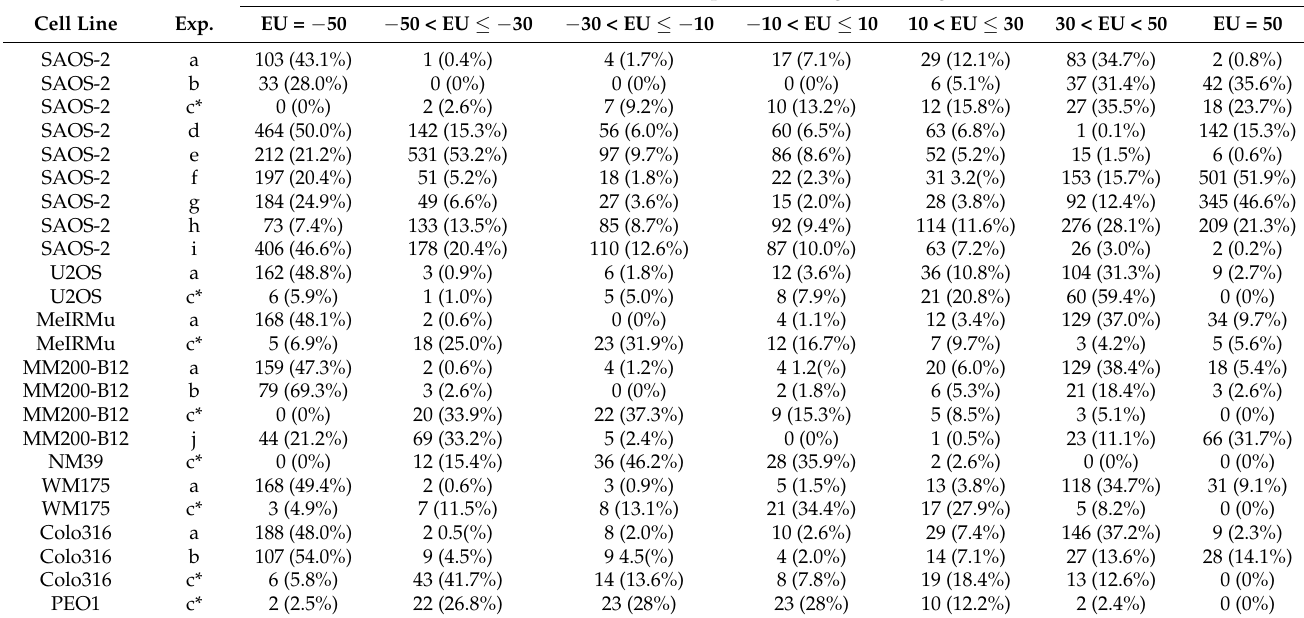
Table 2. The number of co-cultured cells according to Exchange Units (EU) in each experiment. The relative percentage of cells in each co-cultured group is indicated in brackets (%) to aid comparison. Ostesoarcoma (SAOS-2, U2OS), melanoma (MeIRMu, MM200-B12, NM39, WM175), colon carcinoma (Colo316) and ovarian carcinoma (PEO1) cells were studied. All experiments were with human dermal fibroblasts, labelling fibroblasts with DiD and cancer cell lines with DiO, except for experiment ‘i’ where SAOS-2 expressed GFP, and experiment ‘c’ (marked *), where human gingival fibroblasts were used and labelling had the opposite orientation, such that fibroblasts were pre-labelled with DiO and cancer cells with DiD. To aid comparison of results, EU for experiment ‘c’ were multiplied by − 1, effectively inverting the order of groups to bring them into alignment with other experiments. Co-Cultured Cells Grouped According to Exchange Units